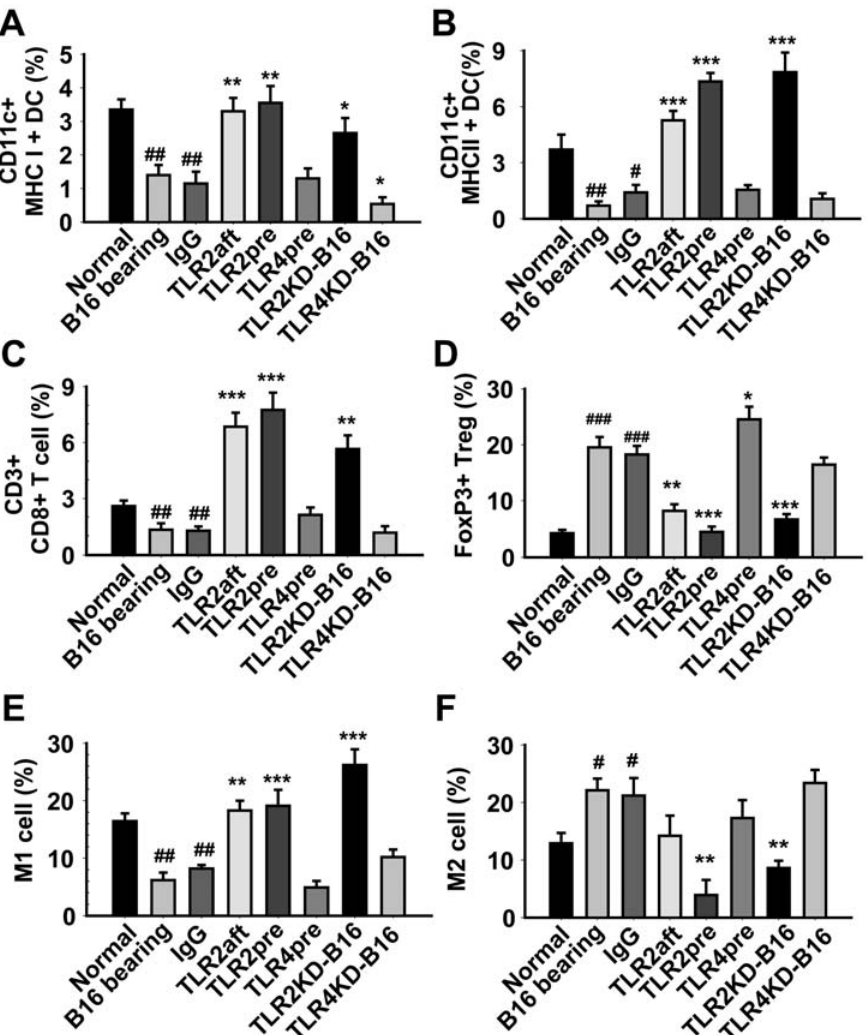
Figure 5. Targeting TLR2 reversed the tumor cell-induced immunosuppressive microenvironment. Animals were treated as indicated in the Figure 3 legend. The lungs were removed, and the lung single cell suspensions were prepared as described in the methods section. The various immune cells, including CD11 + MHC I + cells (A), CD11 + MHC II + cells (B), CD3 + CD4 + and CD3 + CD8 + cells (C), FoxP3 + CD4 + CD25 + Tregs (D), CD11b + F4/ 80 + CD206 2 M1 cells (E) and CD11b + F4/80 + CD206 + M2 cells (F), were detected by flow cytometry. The CD4 + and CD8 + cells were gated from CD3 + cells. The CD4 + CD25 + Tregs were gated from Foxp3 + cells. The M1 and M2 were gated from CD11b + cells. The data are represented as mean percentage of positive cells 6 SE of three independent experiments (n=8/group/experiment). * P , 0.05, ** P , 0.01, *** P , 0.001 versus B16-bearing mice; # P , 0.05, ## P , 0.01, ### P , 0.001 versus normal mice.